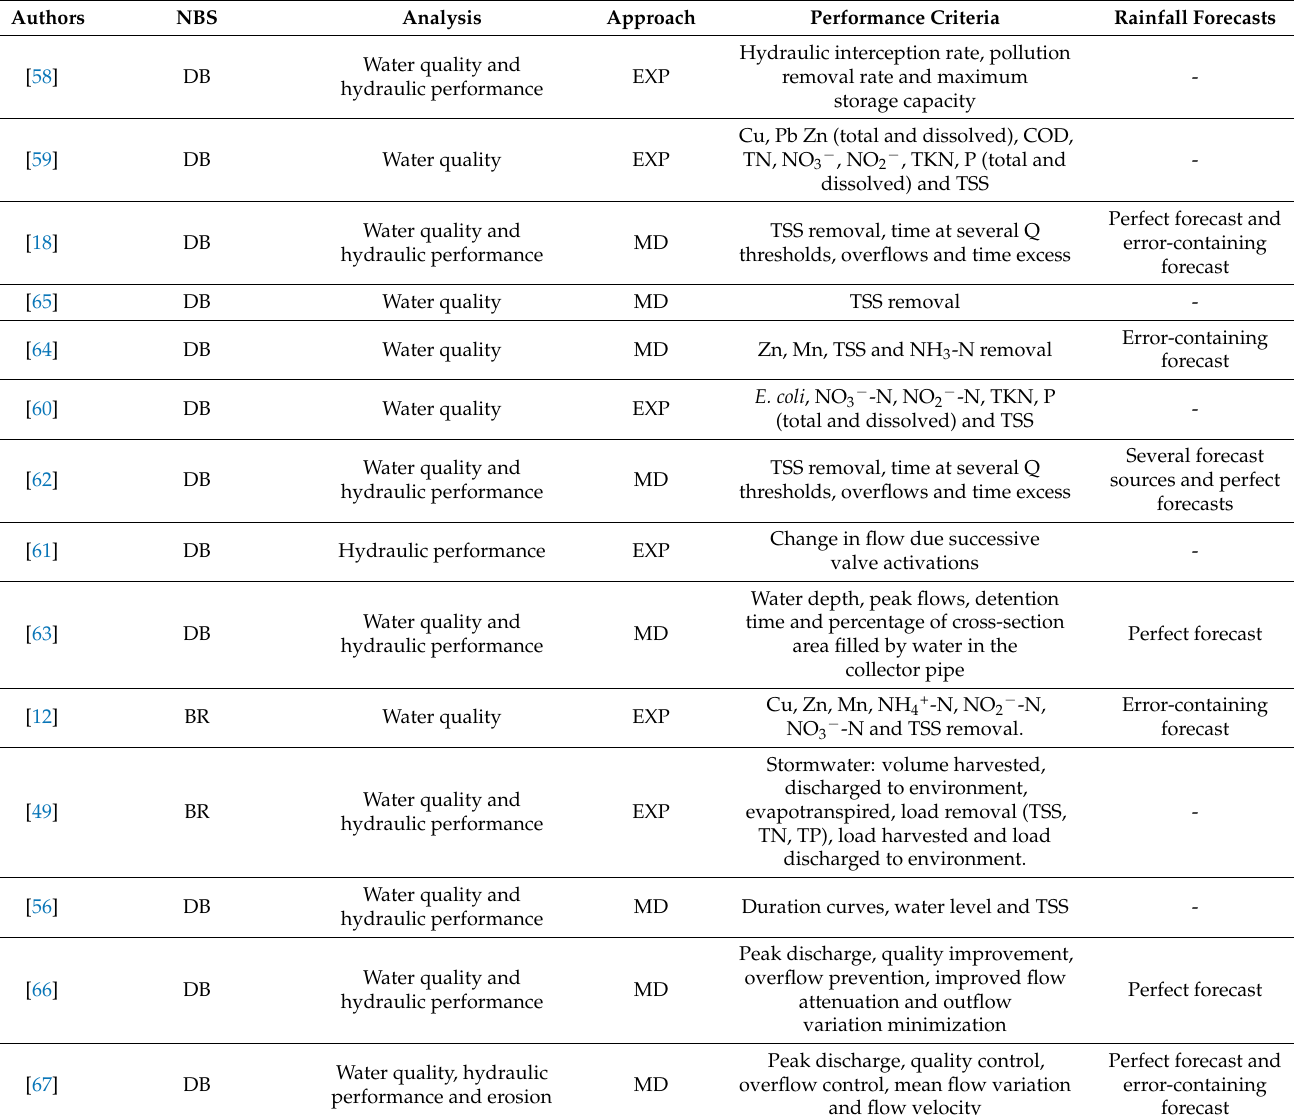
Table 3. Synthesis of studies which uses RTC on